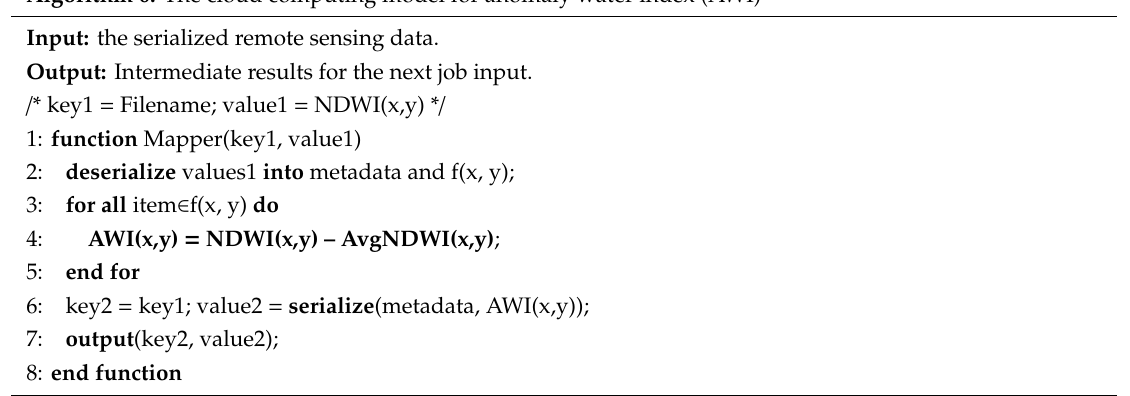
Algorithm 6: The cloud computing model for anomaly water index